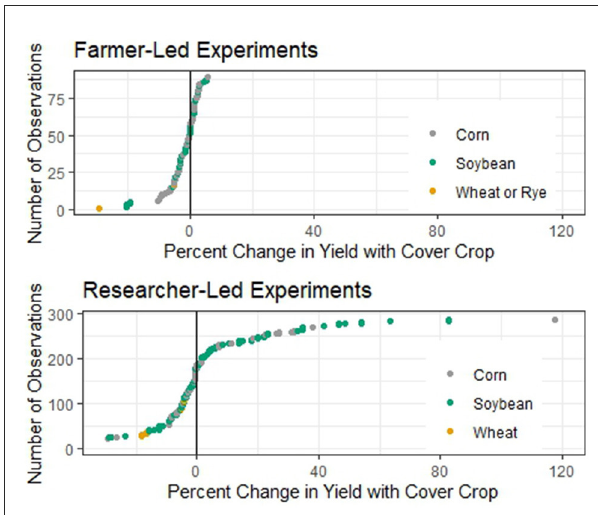
FIGURE3 The change in percent in cash crop grain yield following a cover crop in farmer-led and researcher-led trials for all comparisons in the database. The three crops for which grain yield information was analyzed were corn (gray dots), soybean (green dots), and wheat (orange dots). The vertical black line indicates the average of all experiments.